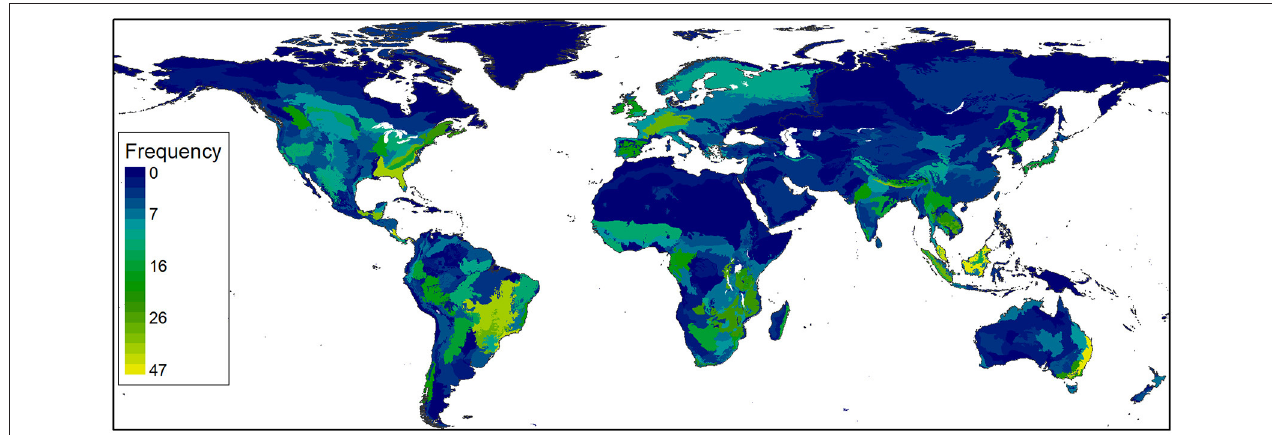
FIGURE 4 | Heat map for frequency of published camera-trapping studies by ecoregion,